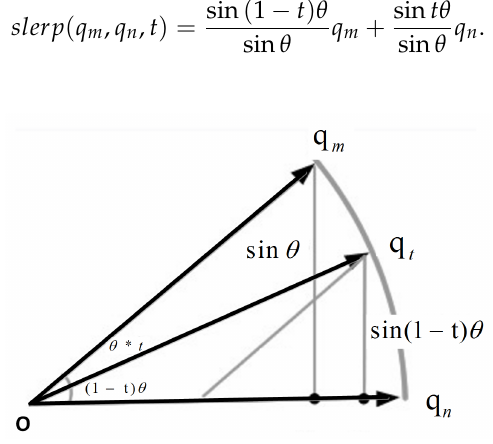
Figure 5. Quaternion